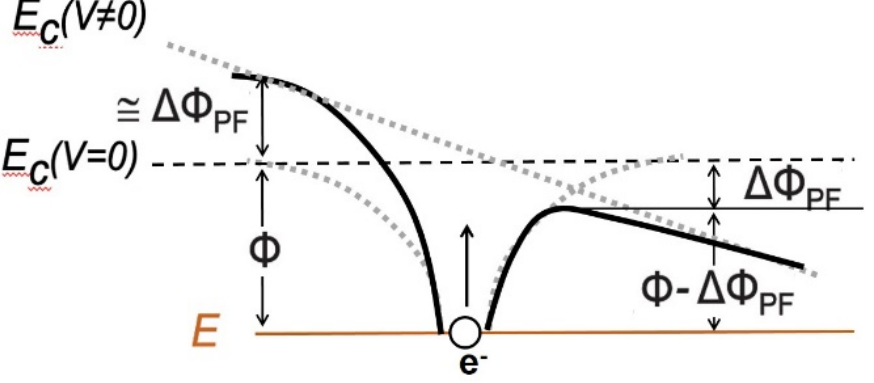
Figure 9. Sketch of the Poole–Frenkel effect without and with applied voltage. Where Ec , Φ , and ∆Φ PF represent the energy of the conduction band, the barrier height and its reduction, respec- tively).